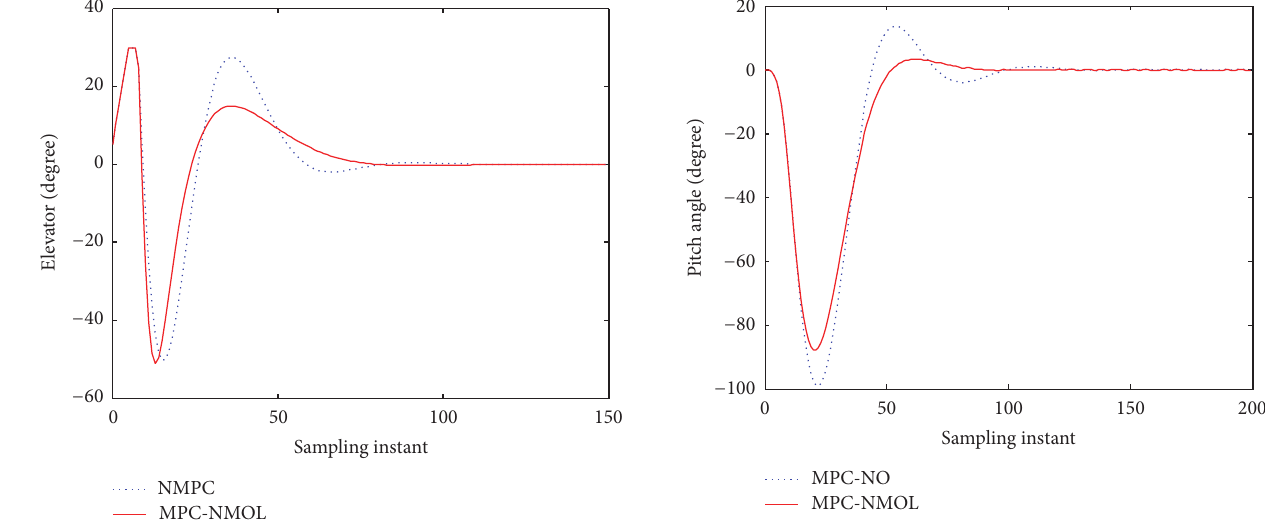
Figure 8: Comparison of pitch angle with disturbance.